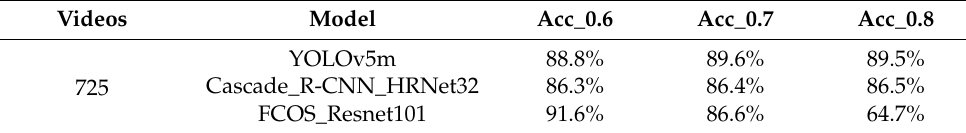
Table 5. Video classification accuracy of the three